Question: Identify the chart type used in this figure.
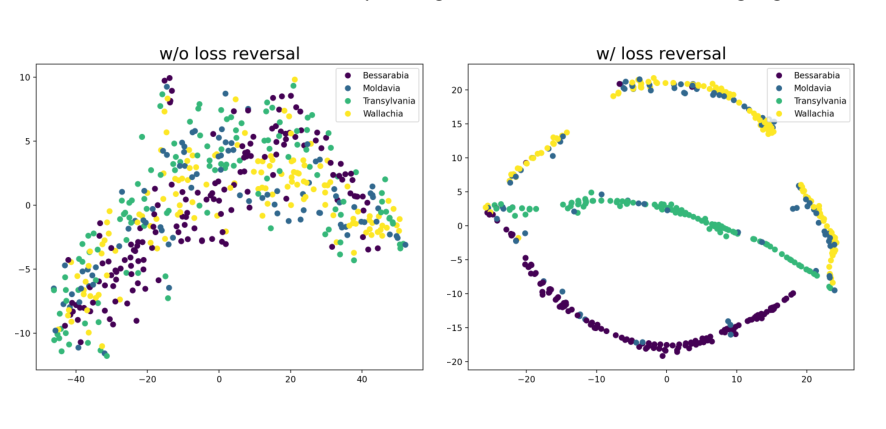
Answer: scatter